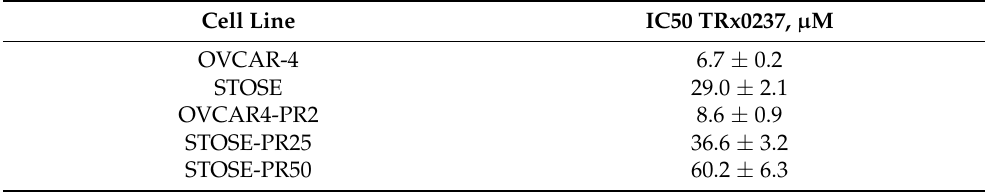
Table 1. IC50 for TRx0237 1